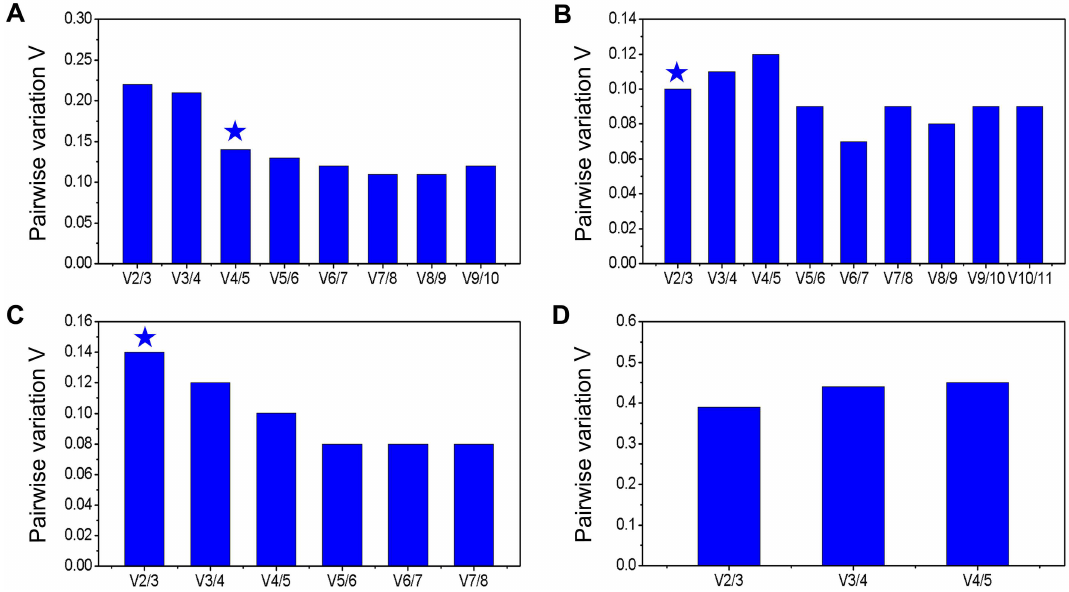
Fig 3. Pairwise variation analyses of candidate referencegenes calculated by geNorm. Pairwise variation (V) was calculated by geNorm to determine the optimal number of reference genes requiredfor accurate normalization in different sample sets: (A) scion leaves of different grafted watermelons submitted to N or P stress, (B) roots of grafted and non- grafted squash submitted to N or P stress, (C) roots of grafted and non-graftedbottle gourd submitted to N or P stress, (D) all scion leaves of different grafted watermelons and roots of grafted and non-grafted rootstocks under normal conditions. The Vn/n+1 value was calculatedfor every comparisonbetween two consecutive candidate reference genes. The inclusion of additionalreference genes is not requiredif the Vn/n+1value less than the recommended 0.15 threshold.